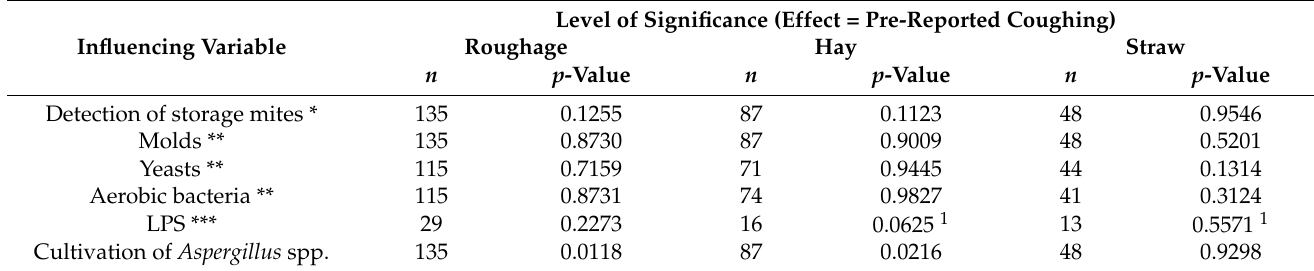
Table 9. Association between hygienic deviations and the occurrence of coughing after feeding in different forage types (according to table analysis and chi-squared or exact Fisher test; control group = routine examination with n = 55 forage samples, thereof 18 straw and 37 hay samples).